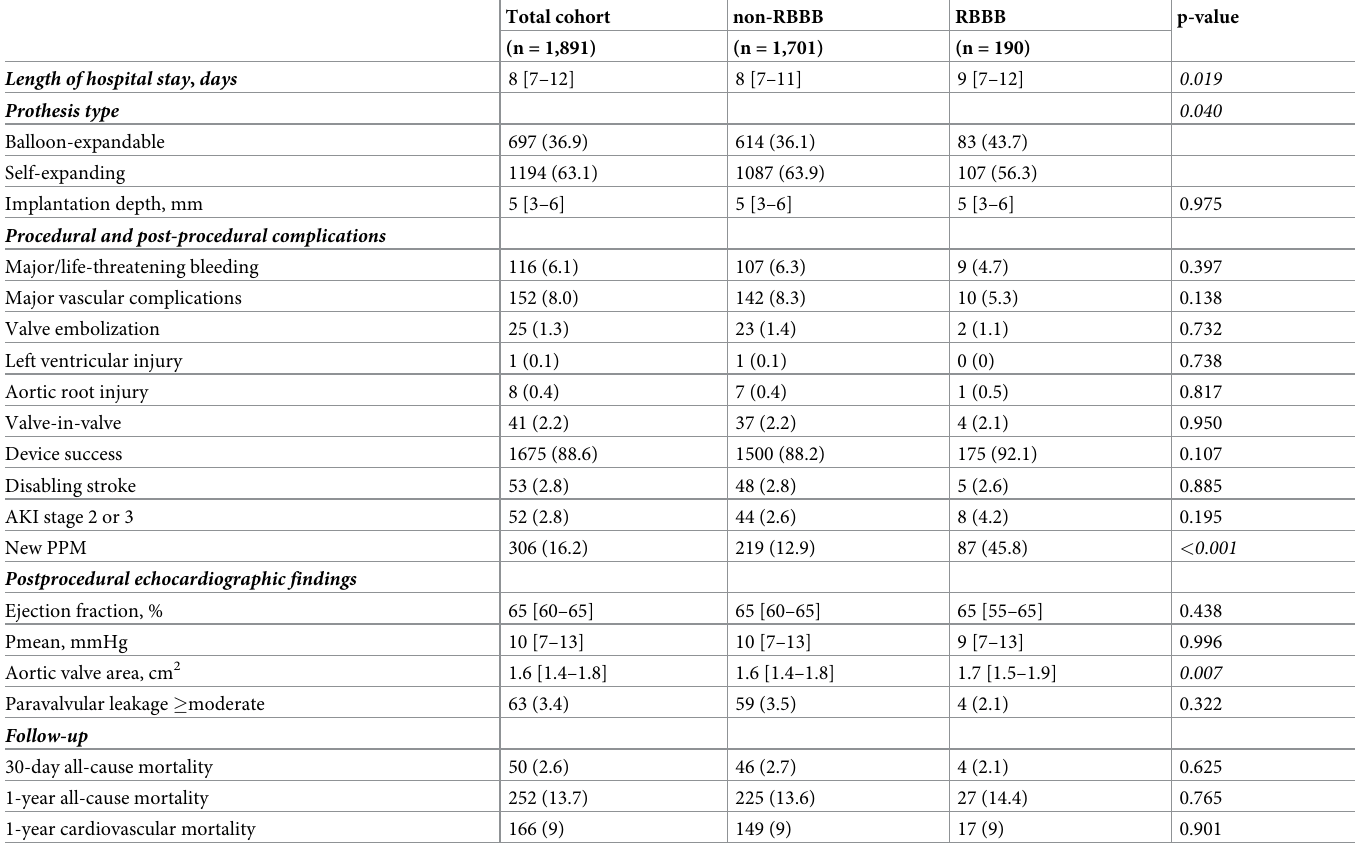
Table 2. Procedural and postprocedural characteristics and